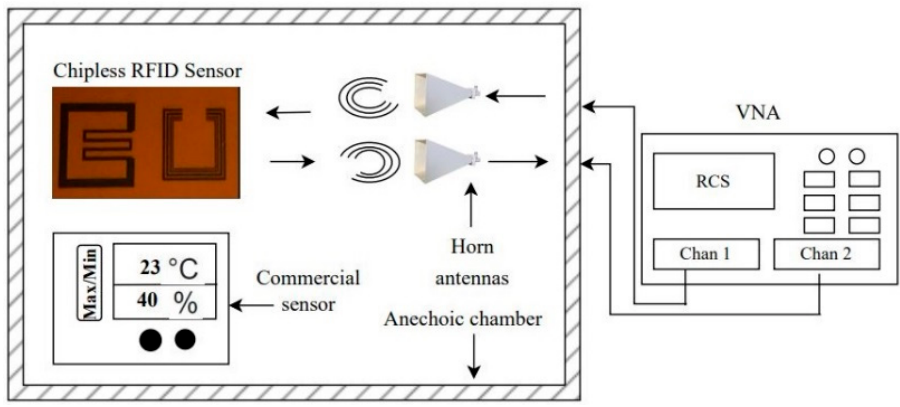
Figure 5. ( a ) Measured and computed RCS response, ( b ) measured tag IDs.